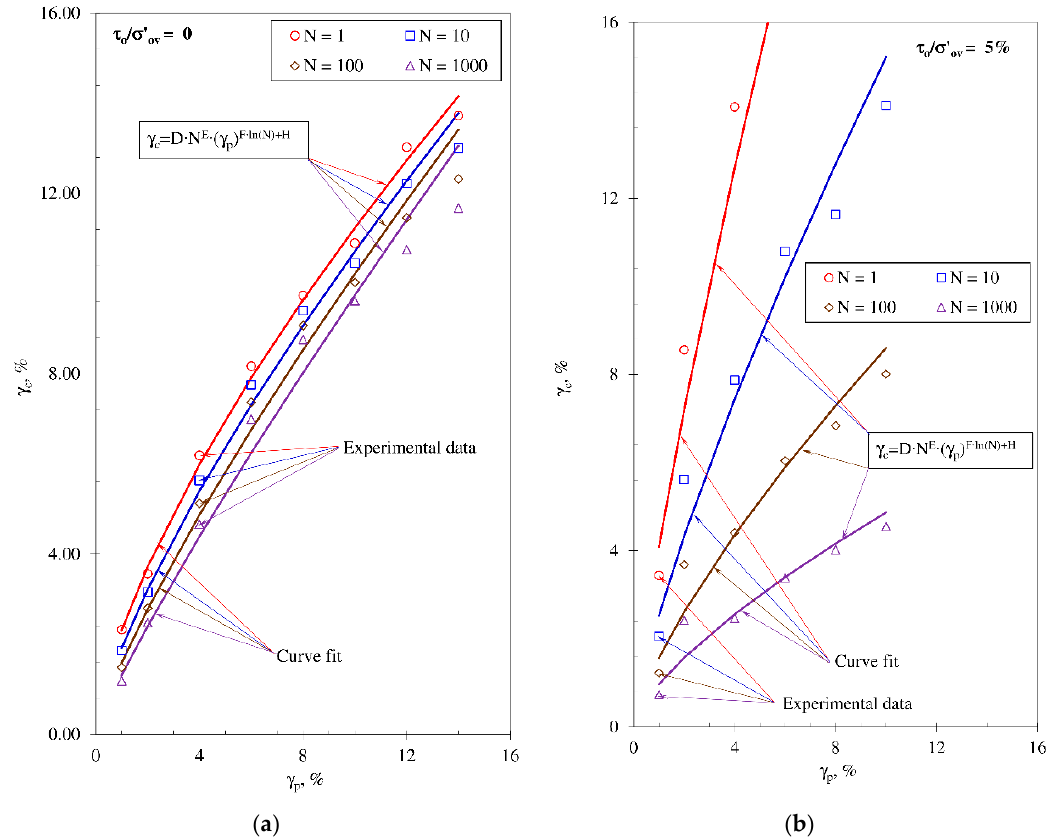
Figure 13. Comparison between experimental results and adjustments obtained by empirical relation (7). Variation of the cyclic shear strain as a function of the permanent shear strain and of the number of cycles corresponding to τ o / σ′ ov = 0 ( a ) and τ o / σ′ ov = 5% ( b ).